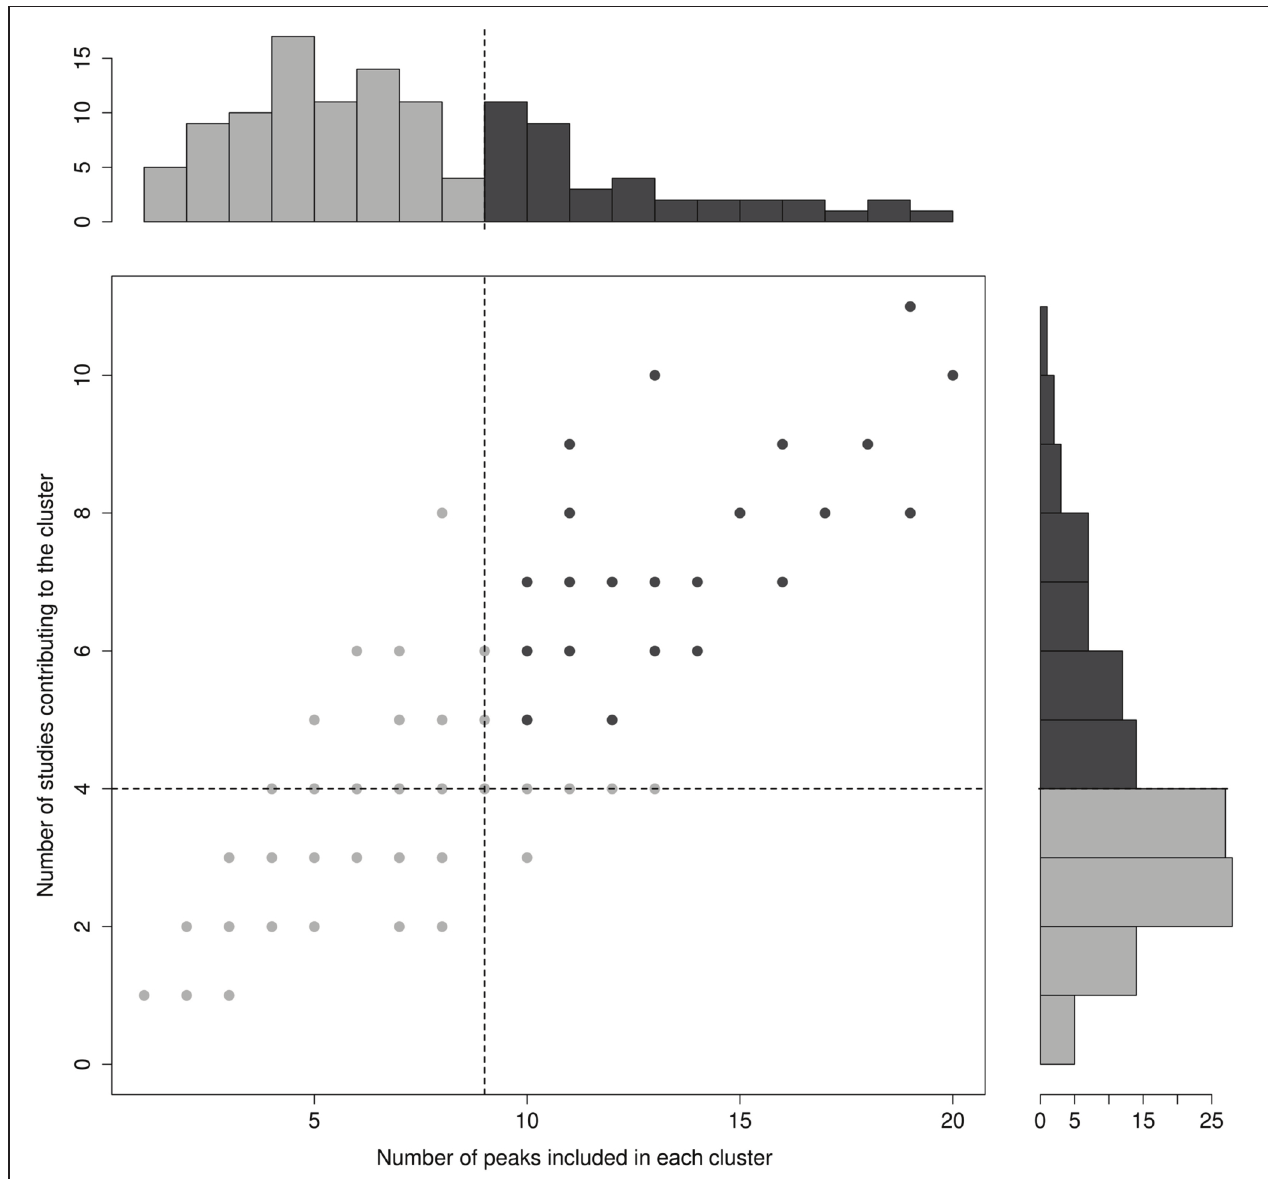
a cluster (note that several points/clusters may overlap because of a same number of studies and peaks included). Unimodal distributions are represented through the histograms in the side panels. Dotted lines represent cut-off